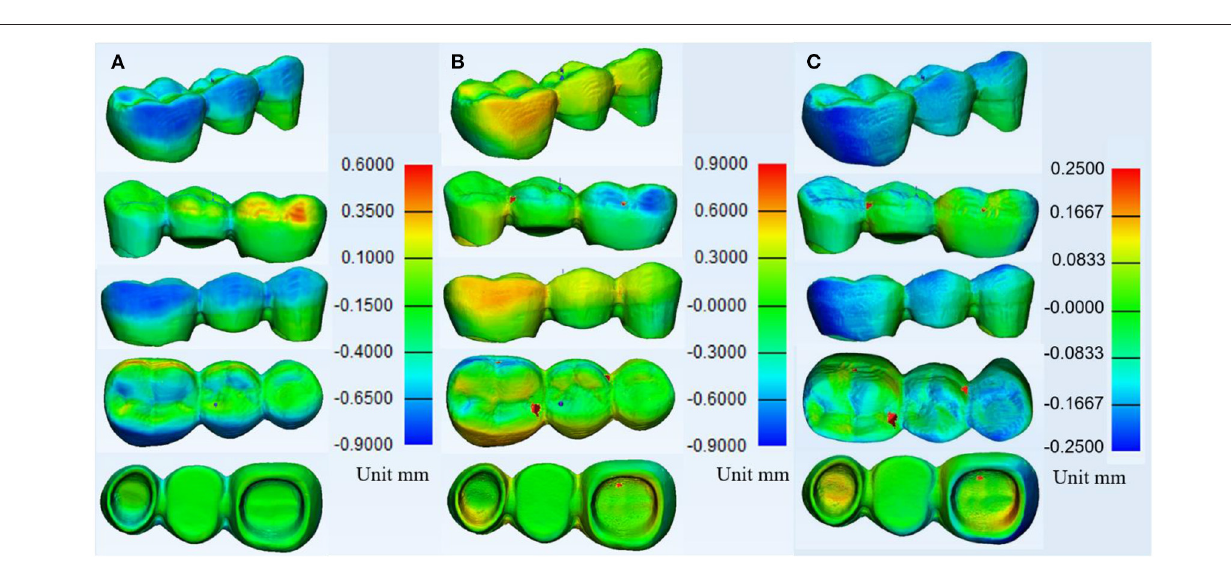
FIGURE 5 | Precision analysis of YSZ bridge (A) reference file vs. machined file, (B) reference file vs. sintered file, and (C) machined file vs. sintered file assuming sintering shrinkage to be 16.5%.